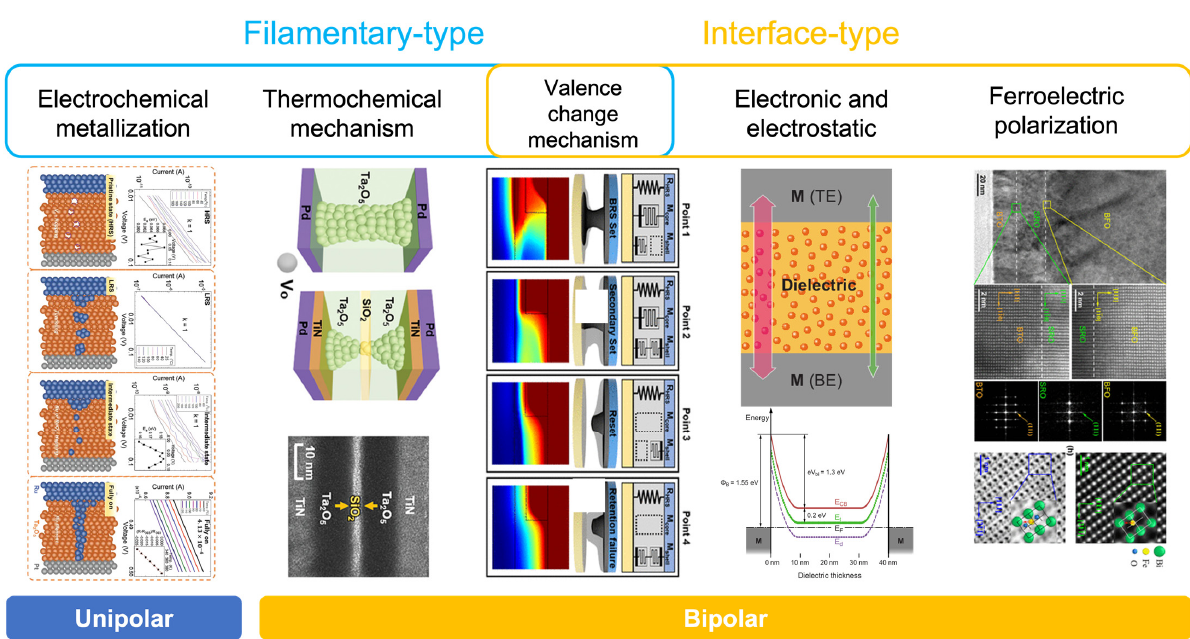
Figure 6. The typical working mechanism of memristors. Filamentary-type and interface-type are the two main categories [99–103]. Reprinted/adapted with permission from Ref. [99] Yoon, 2020. Reprinted/adapted with permission from Ref. [100] Xu, 2019. Reprinted/adapted with permission from Ref. [101] Park 2022. Reprinted/adapted with permission from Ref. [102] Schroeder, 2010. Reprinted/adapted with permission from Ref. [103] Sun, 2020.